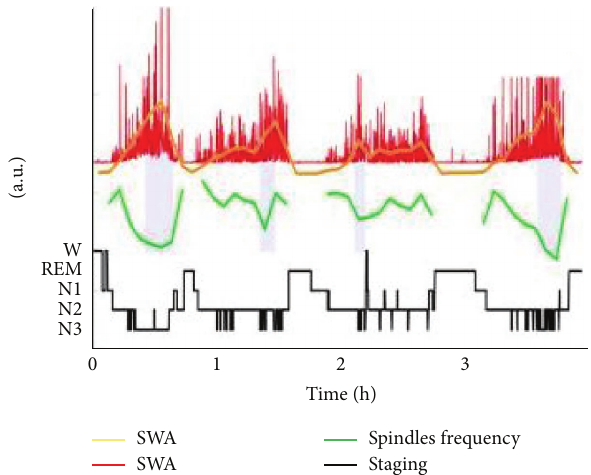
Figure 7: Example of time course of Slow Wave Activity (SWA) and spindle frequency dynamics throughout sleep in the anterior cingulate of one individual. Note that within NREM cycles, spindle frequency is lowest when SWA is highest (vertical purple bars) and increases towards transitions to REM sleep. Modified from